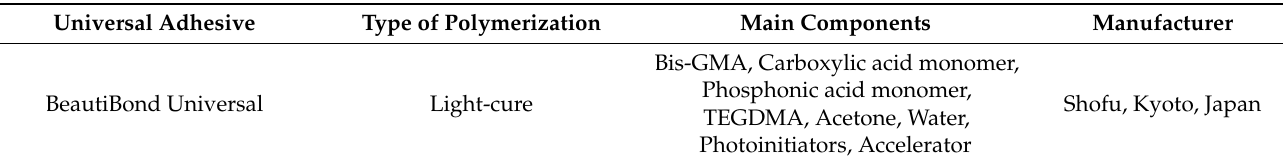
Table 2. Universal adhesives used in this